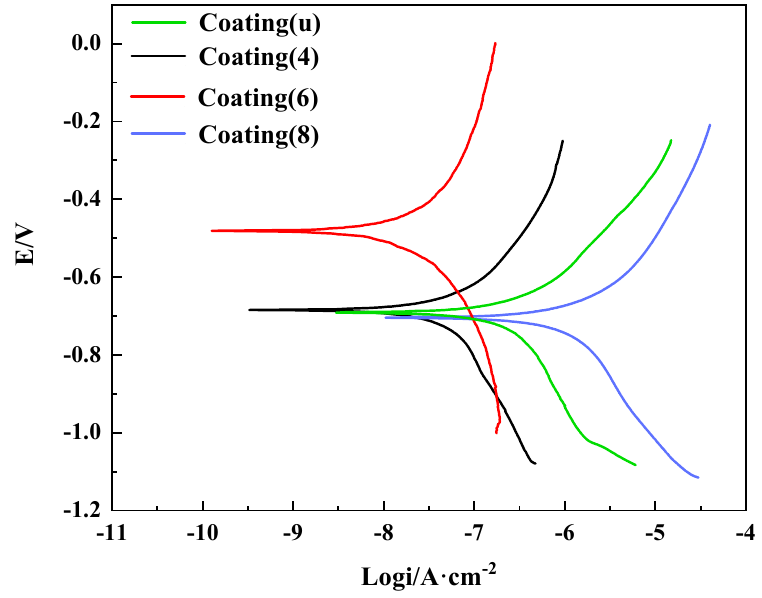
Figure 8. Potentiodynamic polarization curve of coating(u) and coating(x) (x = 4, 6,